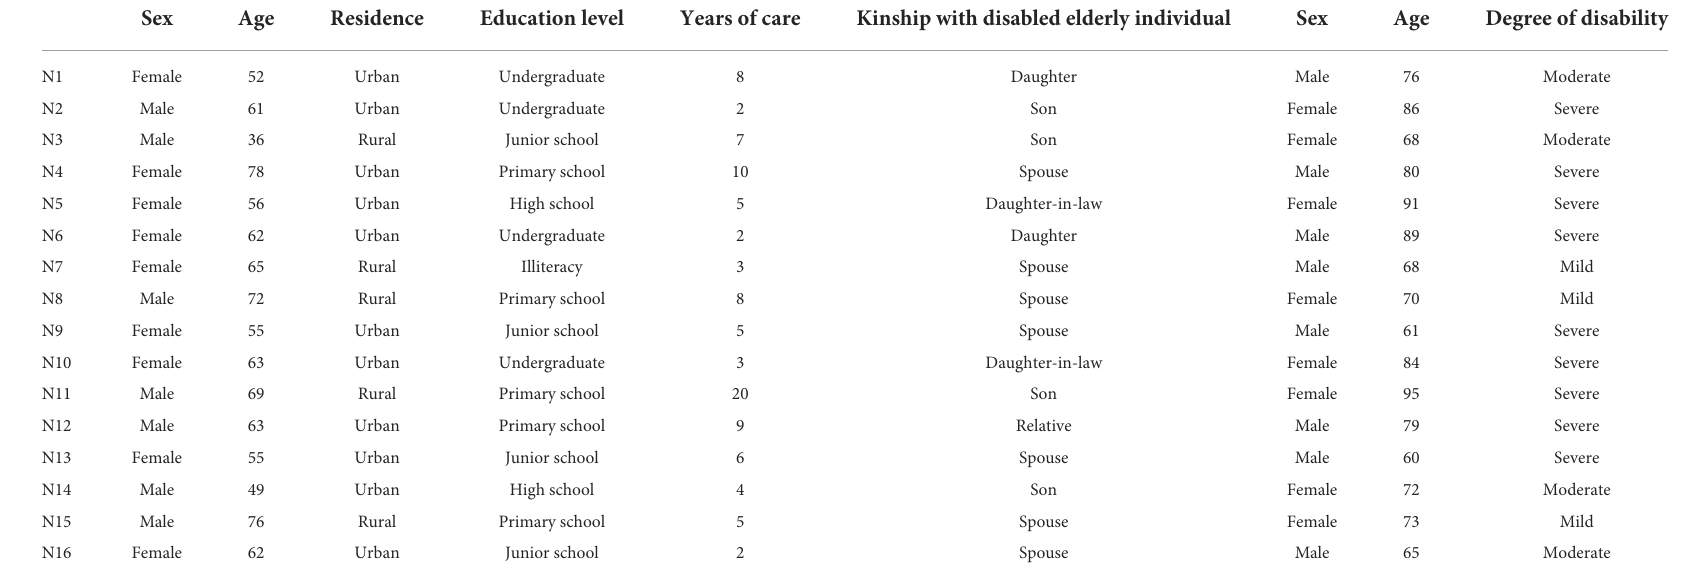
TABLE 1 Demographic characteristics of the informal caregivers and older adults with disabilities ( n = 16 pairs).